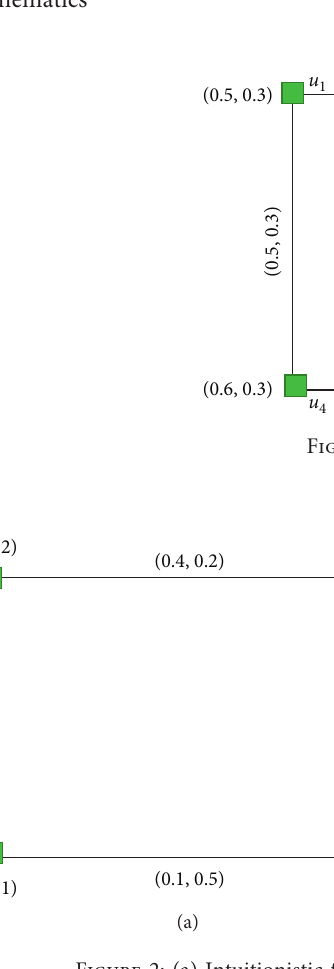
Figure 2: (a) Intuitionistic fuzzy graph. (b) Complement of intuitionistic fuzzy graph.